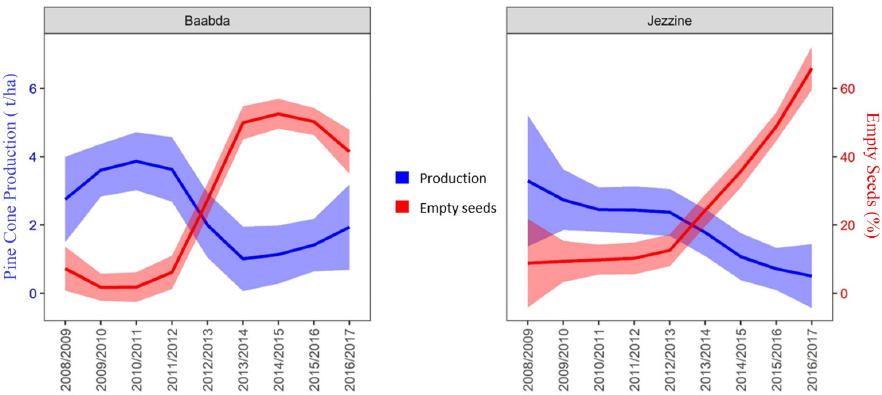
Figure 3. Pine cone production (in blue) and percentage of damaged/empty seeds (in red) over the years in two districts of Lebanon: Baabda (N = 16) and Jezzine (N = 8). Lines represents the mean of replicates (Forest sites), and shades are the 95% confidence interval of the mean.